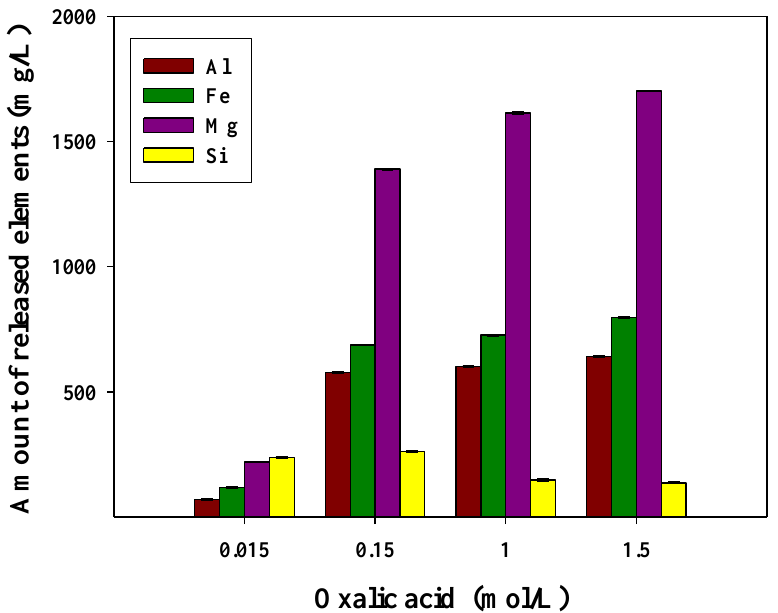
Figure 3. The amount of major elements released following oxalic acid desorption of Cs-adsorbed HBT ( 133 Cs–HBT), used to estimate the degree of dissolution of clay compounds: Al, Fe, Mg, and Si. (n = 3, mean ± standard error of mean). Table 1. Quantification using elemental information from the X-ray fluorescence (XRF) analysis (%).